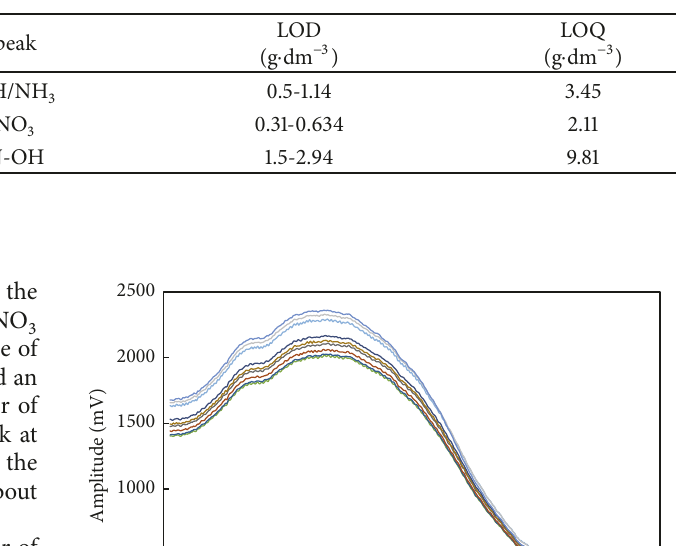
Table 1: Calculated LOD and LOQ (g ⋅ L −1 ).